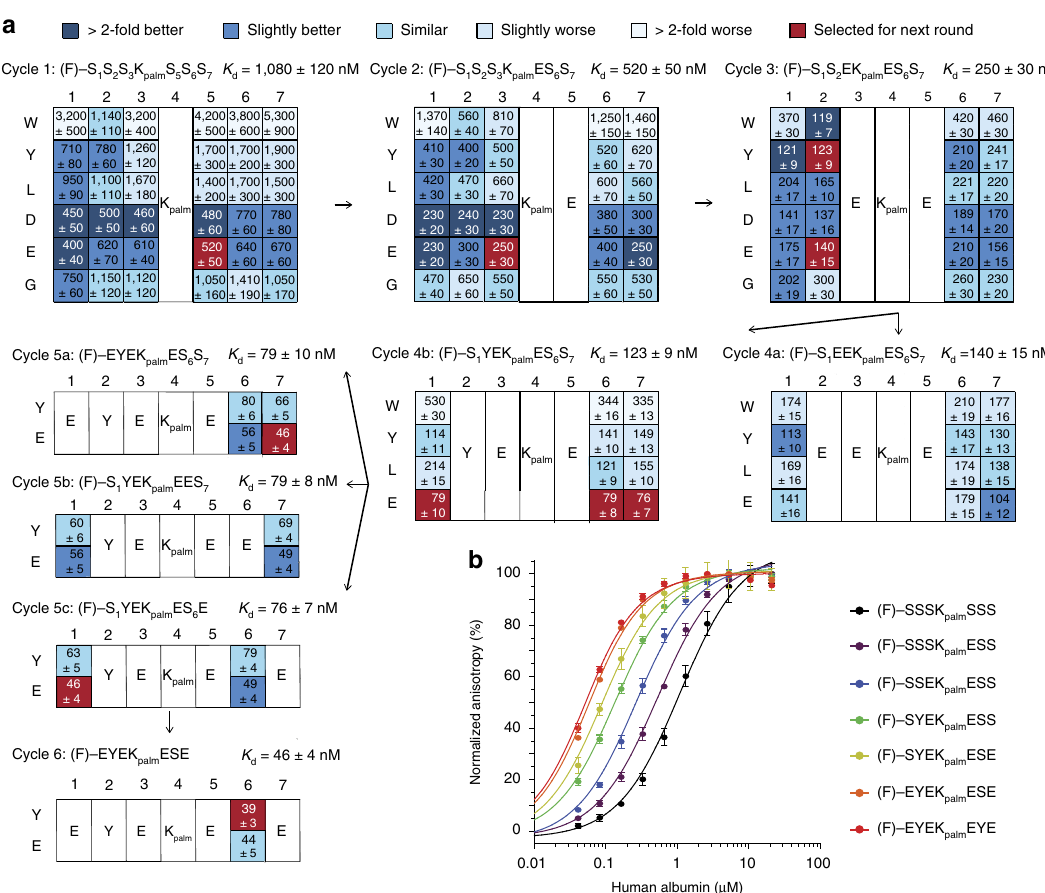
Figure 2 | Evolution of peptide moiety of the tag. ( a ) Six cycles of iterative heptapeptide-palmitoyl tag synthesis and affinity measurement are shown. For each cycle, the sequence of the starting peptide (for example, (F)-S 1 S 2 S 3 K palm S 5 S 6 S 7 ) is shown together with its dissociation constant K d for human albumin. One serine was substituted at the time to the indicated amino acids (W, Y, L, D, E and G) and the affinity of the different heptapeptide-palmitoyl variants are indicated in the boxes. Dark blue or red shaded boxes indicate variants with the best binding affinities. Variants in boxes highlighted in red were used for the next evolution cycle. ( b ) Binding of the best tag variants evolved in the different cycles measured by fluorescence polarization. Average values of at least three measurements and s.d.’s are